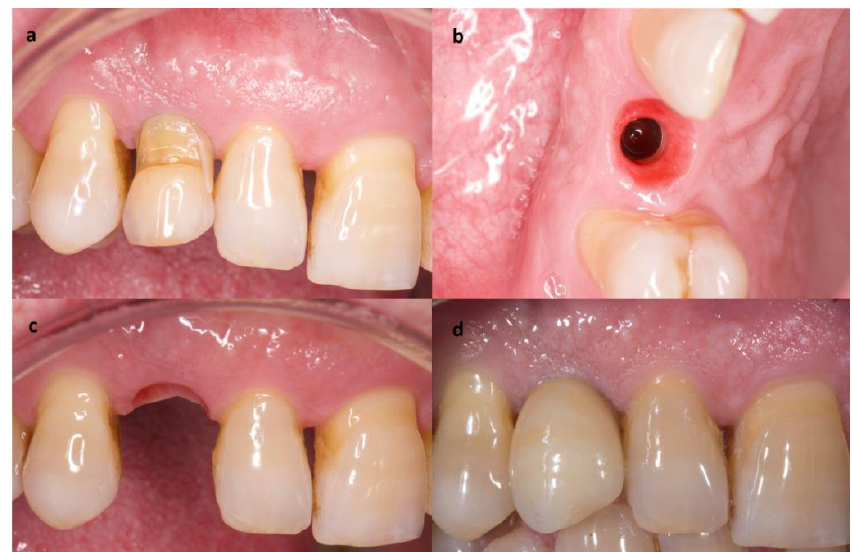
Figure 4. Definitive crown placement process (Case 1). ( a ) Provisional crown made with the temporary canine. ( b ) Occlusal view of adequate soft tissue. ( c ) Buccal view of adequate soft tissue. ( d ) Definitive crown.